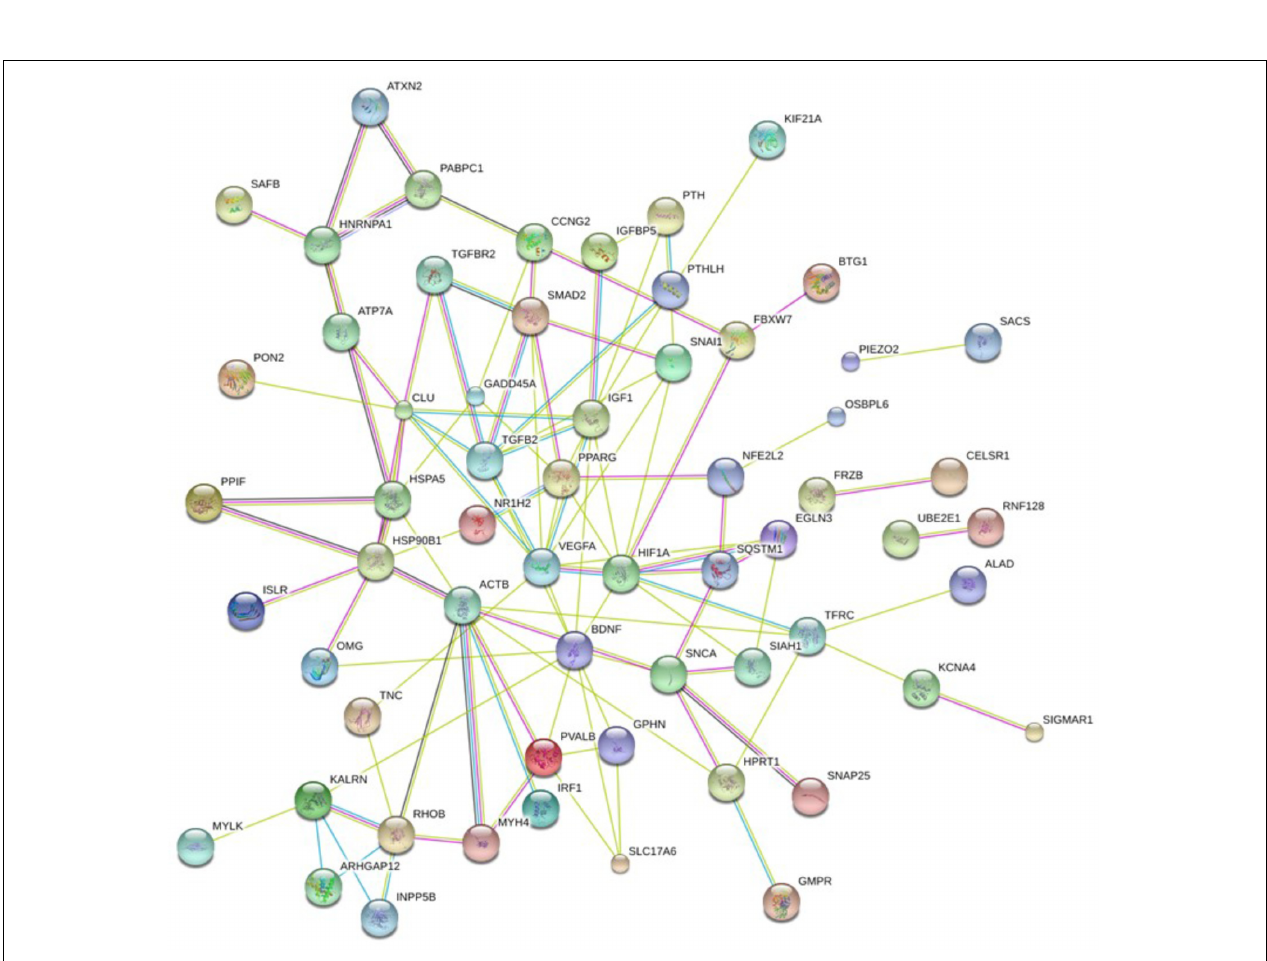
FIGURE 5 | Real-time PCR analyses of significantly dysregulated miRNAs in ALS blood and neuromuscular junction compared to the control blood. p < 0.005. qRT-PCR validation of miRs: representative miRNAs were validated using qRT-PCR. Similar direction of effect was observed as seen in the next-generation sequencing with statistical significance of p < 0.05.